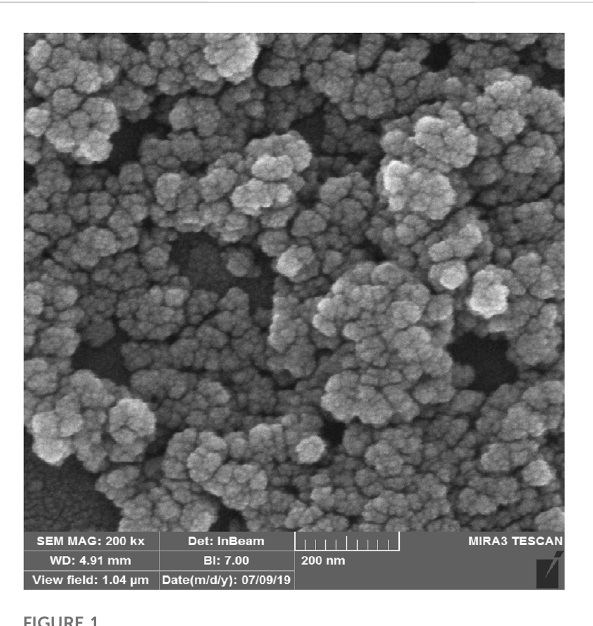
FIGURE 1 SEM image of magnesium oxide nanoparticles.